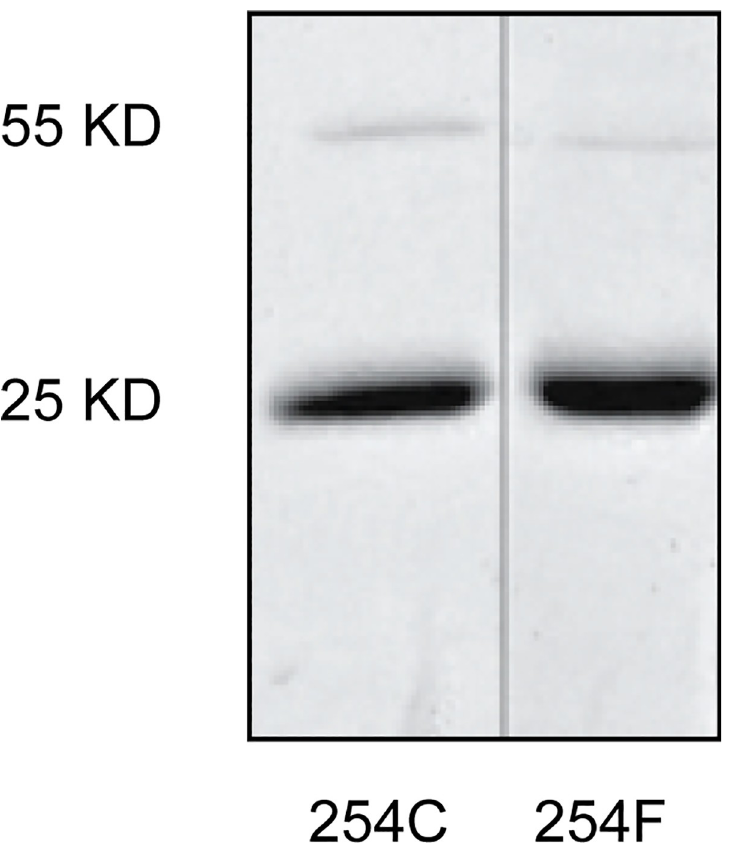
Fig 1. hINMT purified protein. Coomassie stained SDS-PAGE of 254C and 254F allozymes used in the kinetic study indicating the purity and the apparent molecular size.